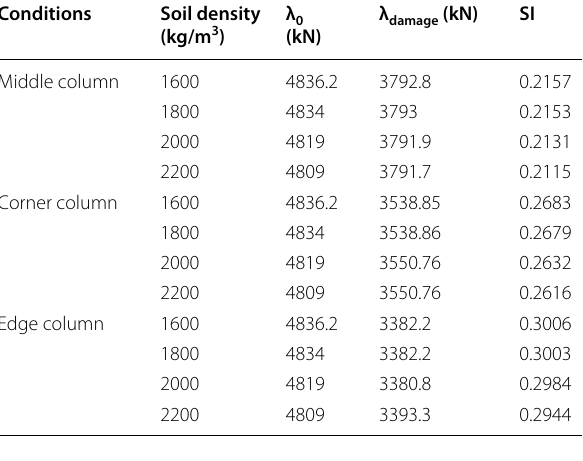
Table 7 Redistribution of the imposed loads in the 20-story RC frames with different densities of substructure soil in FLAC software.